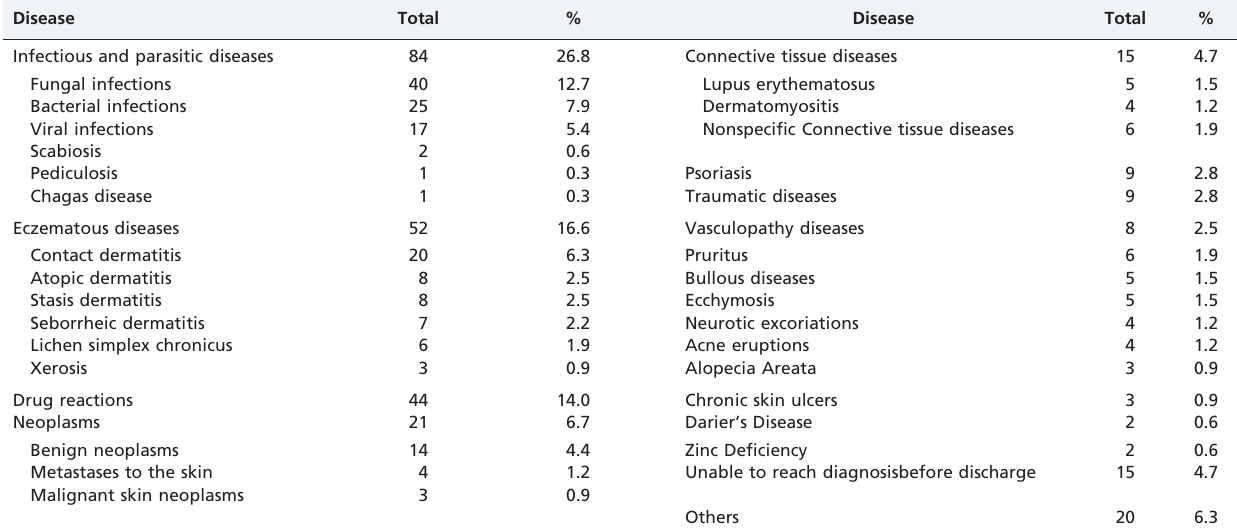
Table 2 - Dermatological Diagnoses.